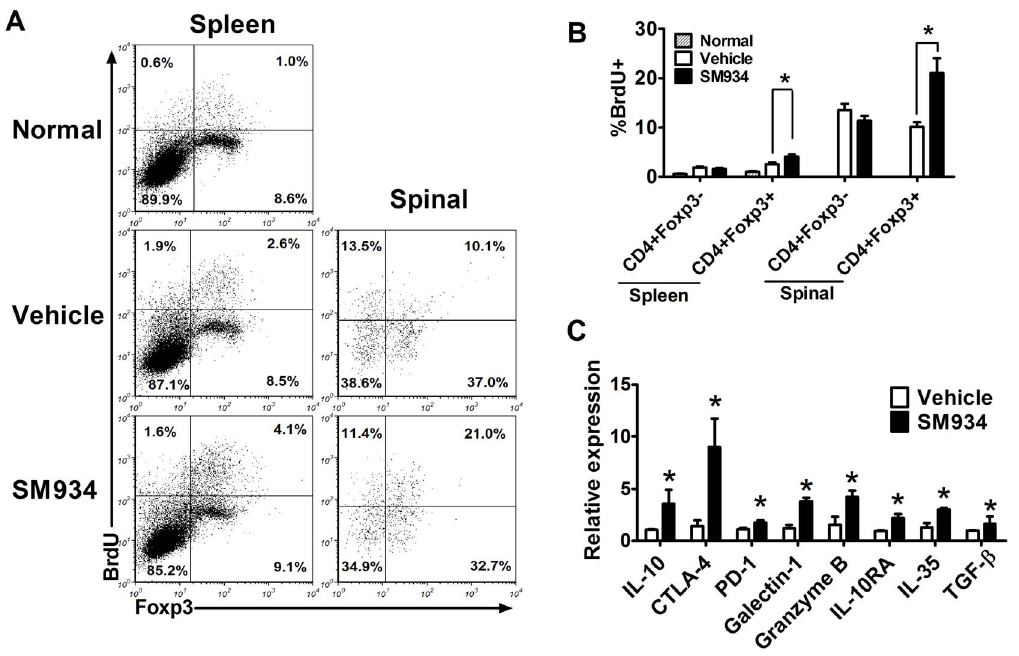
Figure 5. SM934 treatment enhanced Treg cells expansion in EAE mice. (A) Vehicle and SM934 treated mice were given daily i.p. injection of BrdU for 3 days from day 17 p.i., splenocytes and MNC in spinal cord were isolated and analyzed for BrdU incorporation. The proliferative profile was evaluated in CD4 + Foxp3 2 , CD4 + Foxp3 + splenocytes, and CD4 + Foxp3 2 , CD4 + Foxp3 + from spinal cord. (B) Percentage of CD4 + Foxp3 2 , CD4 + Foxp3 + splenocytes, and CD4 + Foxp3 2 , CD4 + Foxp3 + from spinal cord are expressed as mean 6 SEM (n=4). (C) CD4 + T cells were purified by immunomagnetic negative selection from splenocytes, indicated genes expression was analyzed by real-time PCR. Results were expressed as mean 6 SEM. *, p , 0.05 compared with vehicle control. Three independent experiments were performed with similar results.